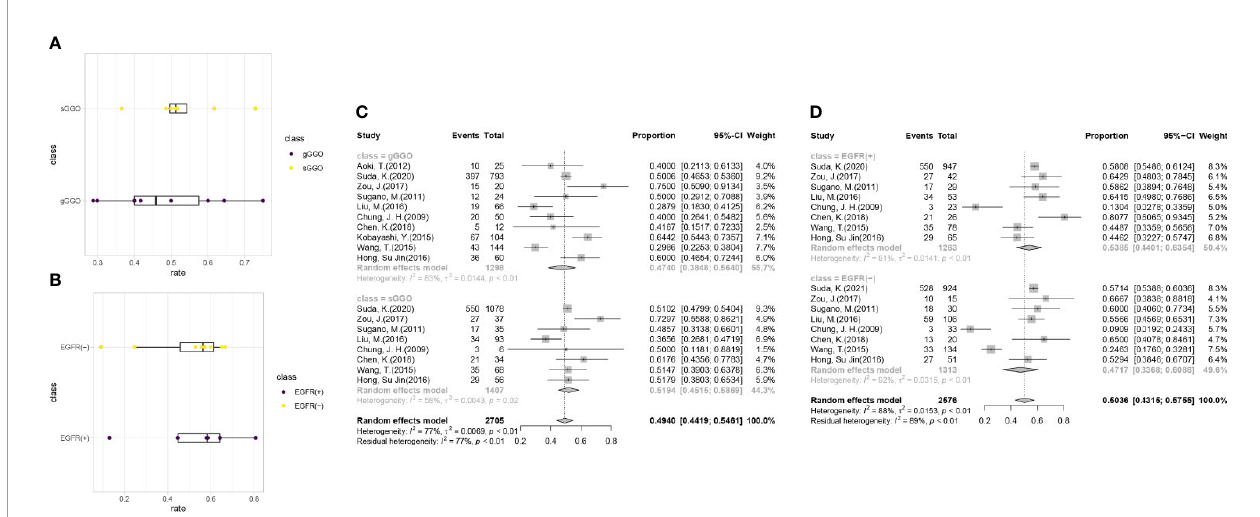
FIGURE 3 | Subgroup analysis for the EGFR mutations. (A) The distribution of the EGFR gene mutation rates in the subgroups with a different radiological density. (B) The distribution of sGGOs in the subgroups with a different status of EGFR mutation. (C) Forest plots from the subgroup meta-analysis of EGFR alterations in GGOs with different radiological subtypes. (D) Forest plots from the subgroup meta-analysis of the percentage of sGGOs in GGOs with a different status of EGFR mutation. gGGO, ground-glass dominant GGO; 50%<G/T ratio ≤ 100%; sGGO, solid dominant GGO; 0<G/T ratio ≤ 50%.